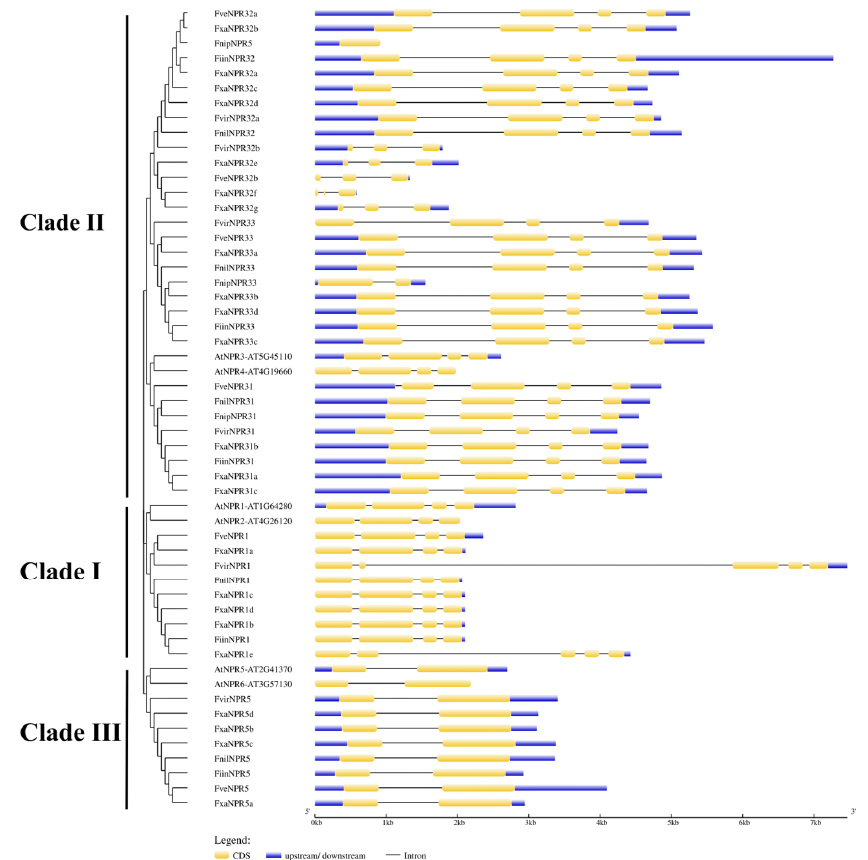
Figure 2. The comparative organization of exons and introns in 48 strawberry NPR1 -like genes and 6 AtNPRs . The structure was produced with the gene structure display server (GSDS) at http://gsds. represent the un-translated regions (UTR) and the coding sequences (CDS), respectively. The neighbor- joining tree of the NPR1 -like genes was generated with MUSCLE clustering by MEGA7.0 for CDS nucleotide